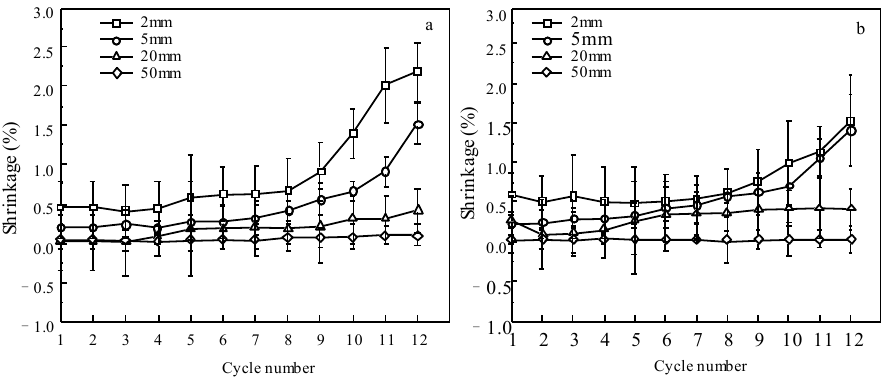
Figure 7. Shrinkage of specimens with lengths of 2, 5, 20, and 50 mm in the ( a ) tangential and ( b ) radial directions.